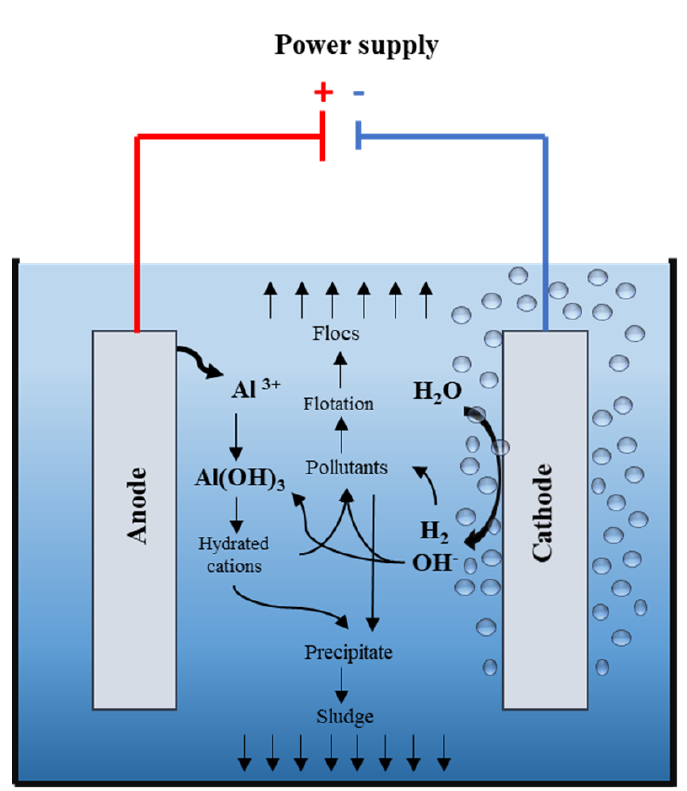
Figure 1. A schematic sketch of the electrocoagulation process. However, other ionic species might be present in the solution depending on the pH values of the medium, such as dissolved Al ( OH ) 2 + , Al 2 ( OH ) 4 + and Al ( OH ) − hydroxide 4 2 complexes. The pollutants can be removed from the wastewater using the aluminum hydroxides by sorption, co-precipitation or electrostatic attraction, followed by coagula- tion [3]. Several studies have demonstrated the high removal efficiency of heavy metal using electrocoagulation (Table 1). Although electrocoagulation has shown high removal efficiency for different pollu- tants from wastewater, the energy and electrode consumption of EC need to be further improved. Recently, increased attention has been placed on the use of dielectrophoretic force (DEP) in electrocoagulation [14–16]. Alkhatib et al. (2020) evaluated the impact of using DEP force in the EC process for the removal of total phosphorus (TP) and chemical oxygen demand (COD) from secondary treated wastewater [14]. The removal of TP and COD increased by 24% and 18%, respectively, using an electrode configuration that